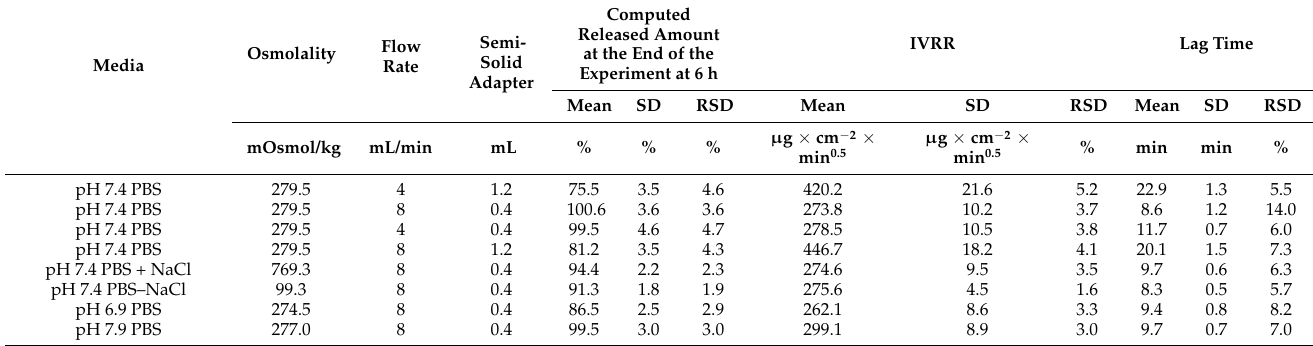
Table 5. In vitro release test (IVRT) results of preliminary experiments.